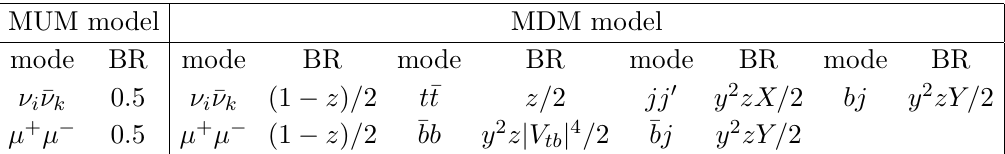
(cid:12) (cid:12) j V td j 2 + j V ts j 2 + 2 < ( V (cid:3) ts V td )